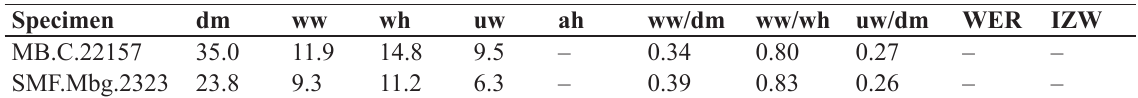
Table 2. Conch dimensions and ratios of selected specimens of Pseudoprobeloceras applanatum (Wedekind,